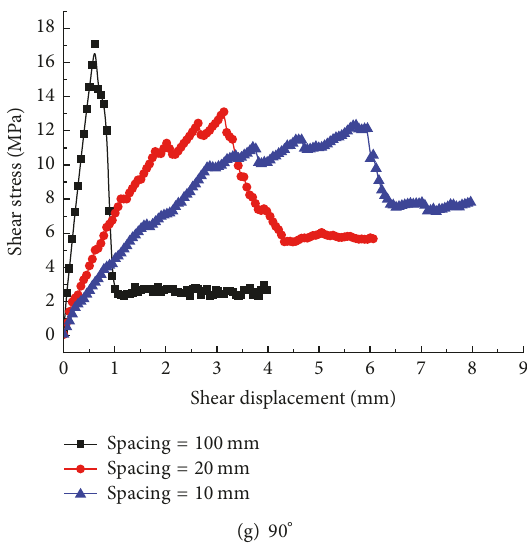
Figure 14: Shear stress-shear displacement curves of the specimens with different bedding plane geometries.